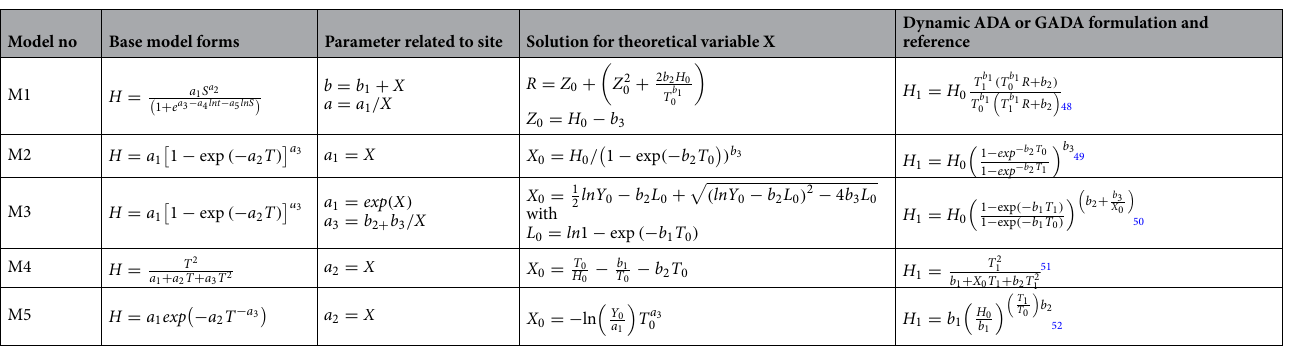
Table 2. The dynamic generalised algebraic difference approach (GADA) and algebraic difference approach (ADA) formulation of growth functions tested in height growth model development. Where H is the tree height , S site index, X and X 0 theoretical variable representing site conditions, T tree age , H 1 is the measured height at age T 1 , H 0 is a site parameter denoting stand height at age T 0 , and a 1 , a 2 , a 3 , a 4 , a 5 , b 1 , b 2 , and b 3 are model